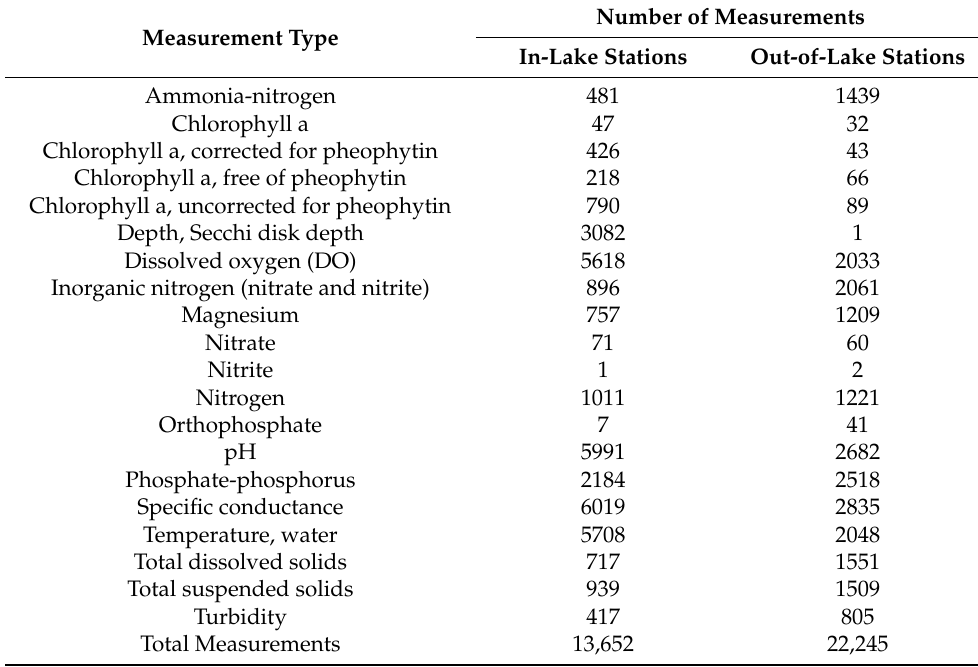
Table 3. Utah Lake AWQMS measurements included in WQDV for our case